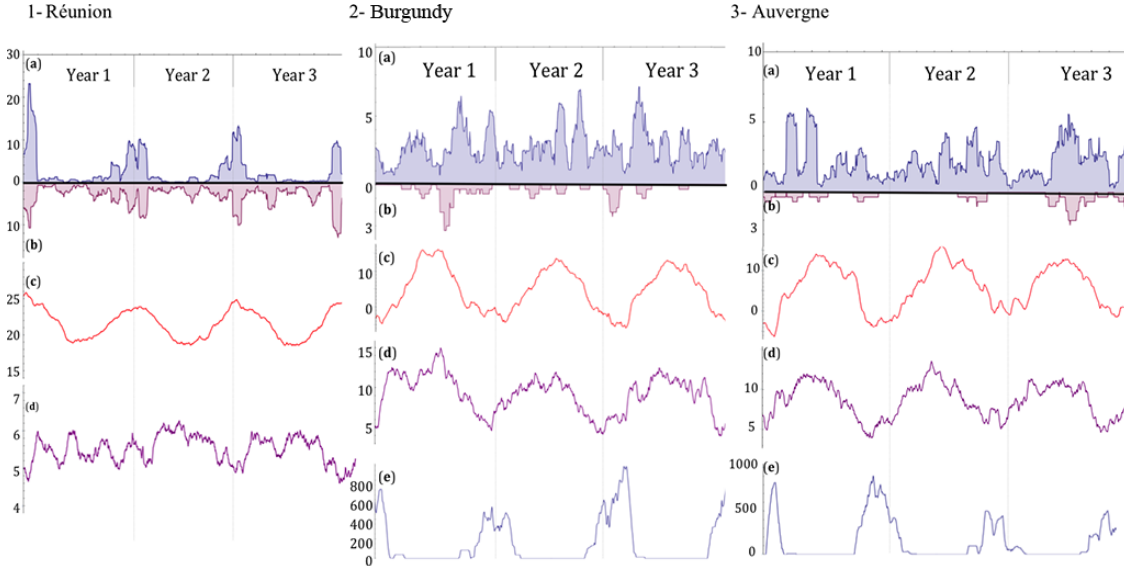
Figure 2. Temperature, rainfall, and rockfall for a 3-year period for the three studied sites (30-day moving average). (a) Precipitation (mm of rain). (b) Rockfall. (c) Minimum of temperature ( ◦ C). (d) Daily temperature amplitude ( ◦ C). (e) Duration of the freezing period (min).